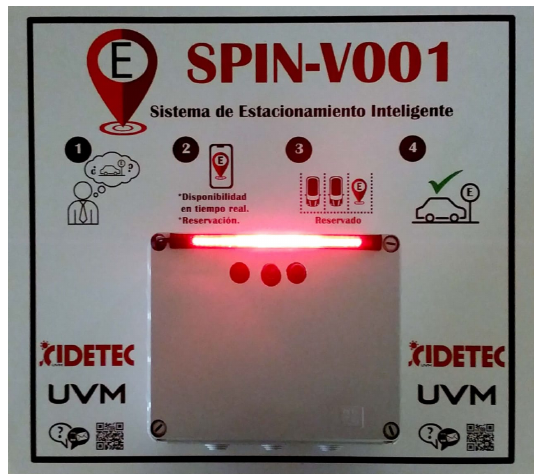
Figure 17. SPIN-V sensor mounted in the back end of the parking space.